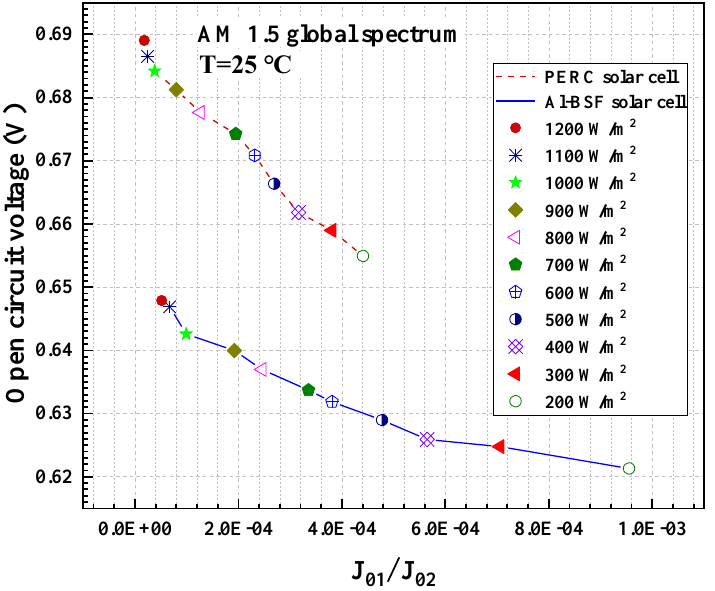
Figure 8. Variation in open-circuit voltage ( V oc ) with the J 01 / J 02 ratio for PERC and Al-BSF silicon solar cells under different injection levels.